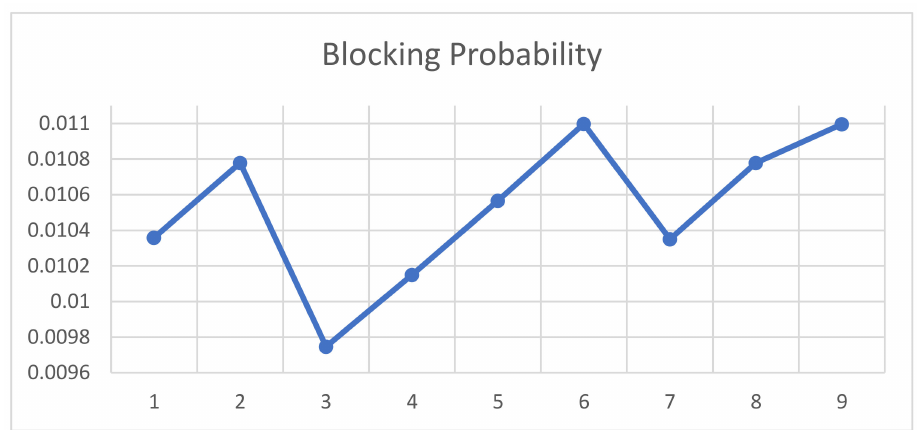
Figure 8. Rejection probability for the top nine portfolios in the baseline case.